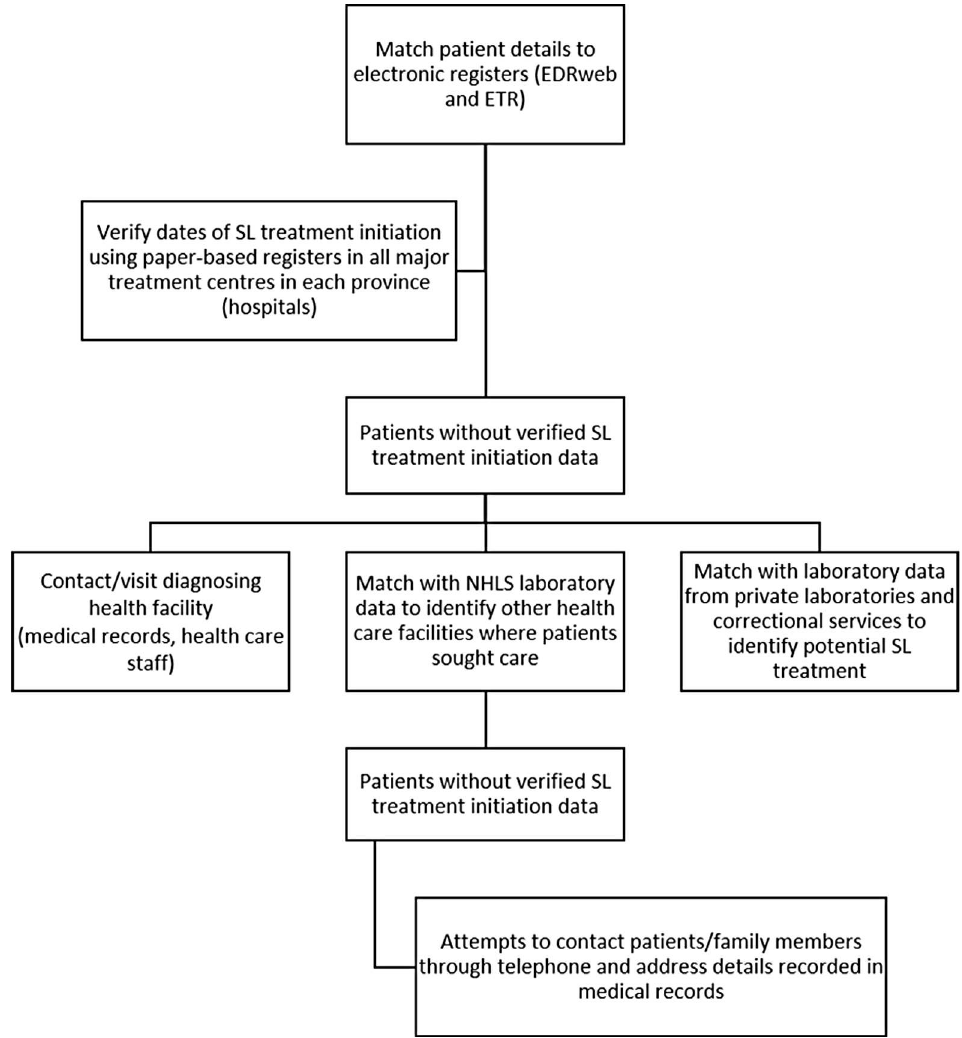
Fig 1. Schematic diagram illustrating the stepwise process for follow-up of cohort patients. EDR, EDR. Net; NHLS, NationalHealth LaboratoryService; SL, second-line.